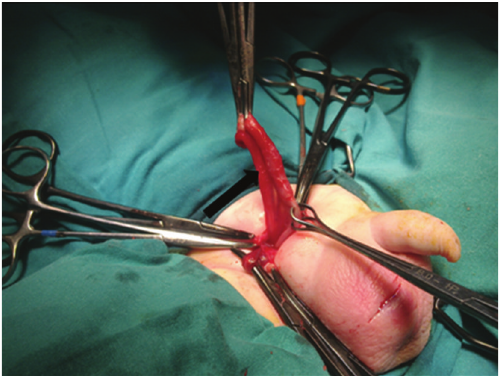
Figure 3: The contents of hernia sac: